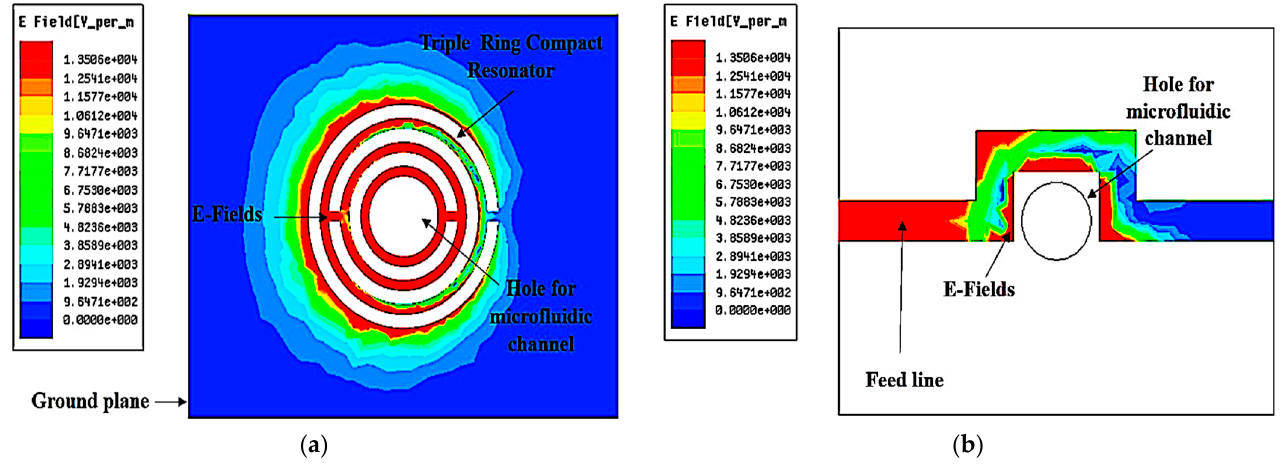
Figure 4. Distribution of triple-rings sensor electric fields. ( a ) Ground plane. ( b ) Feed